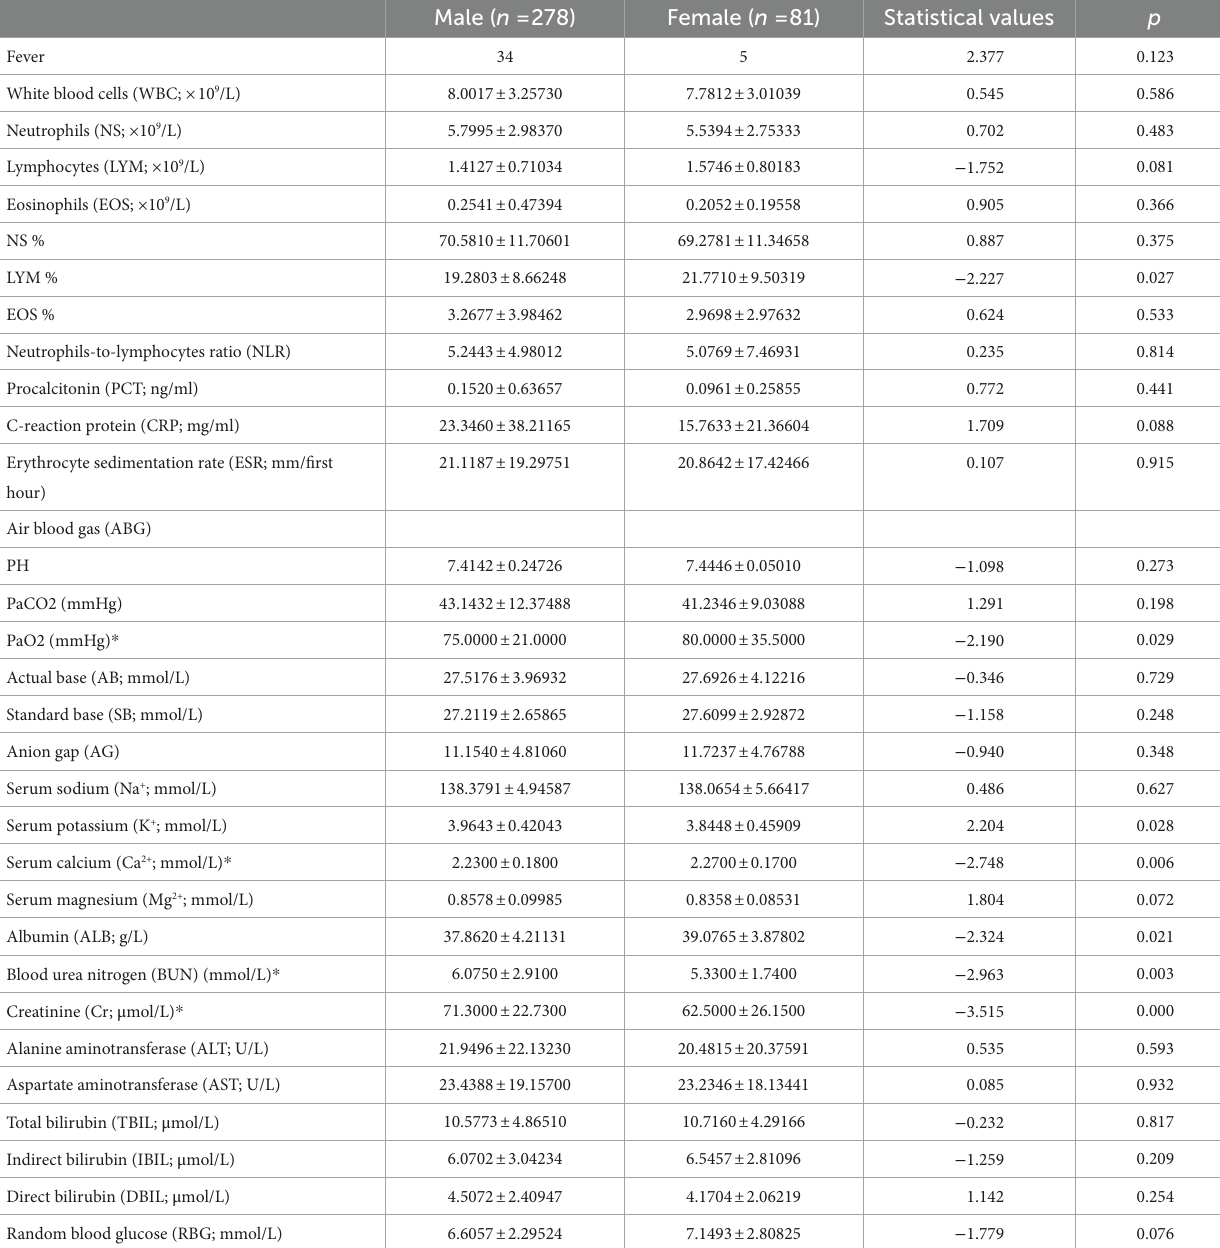
TABLE 2 Clinical features and laboratory data of patients with AECOPD ( n =